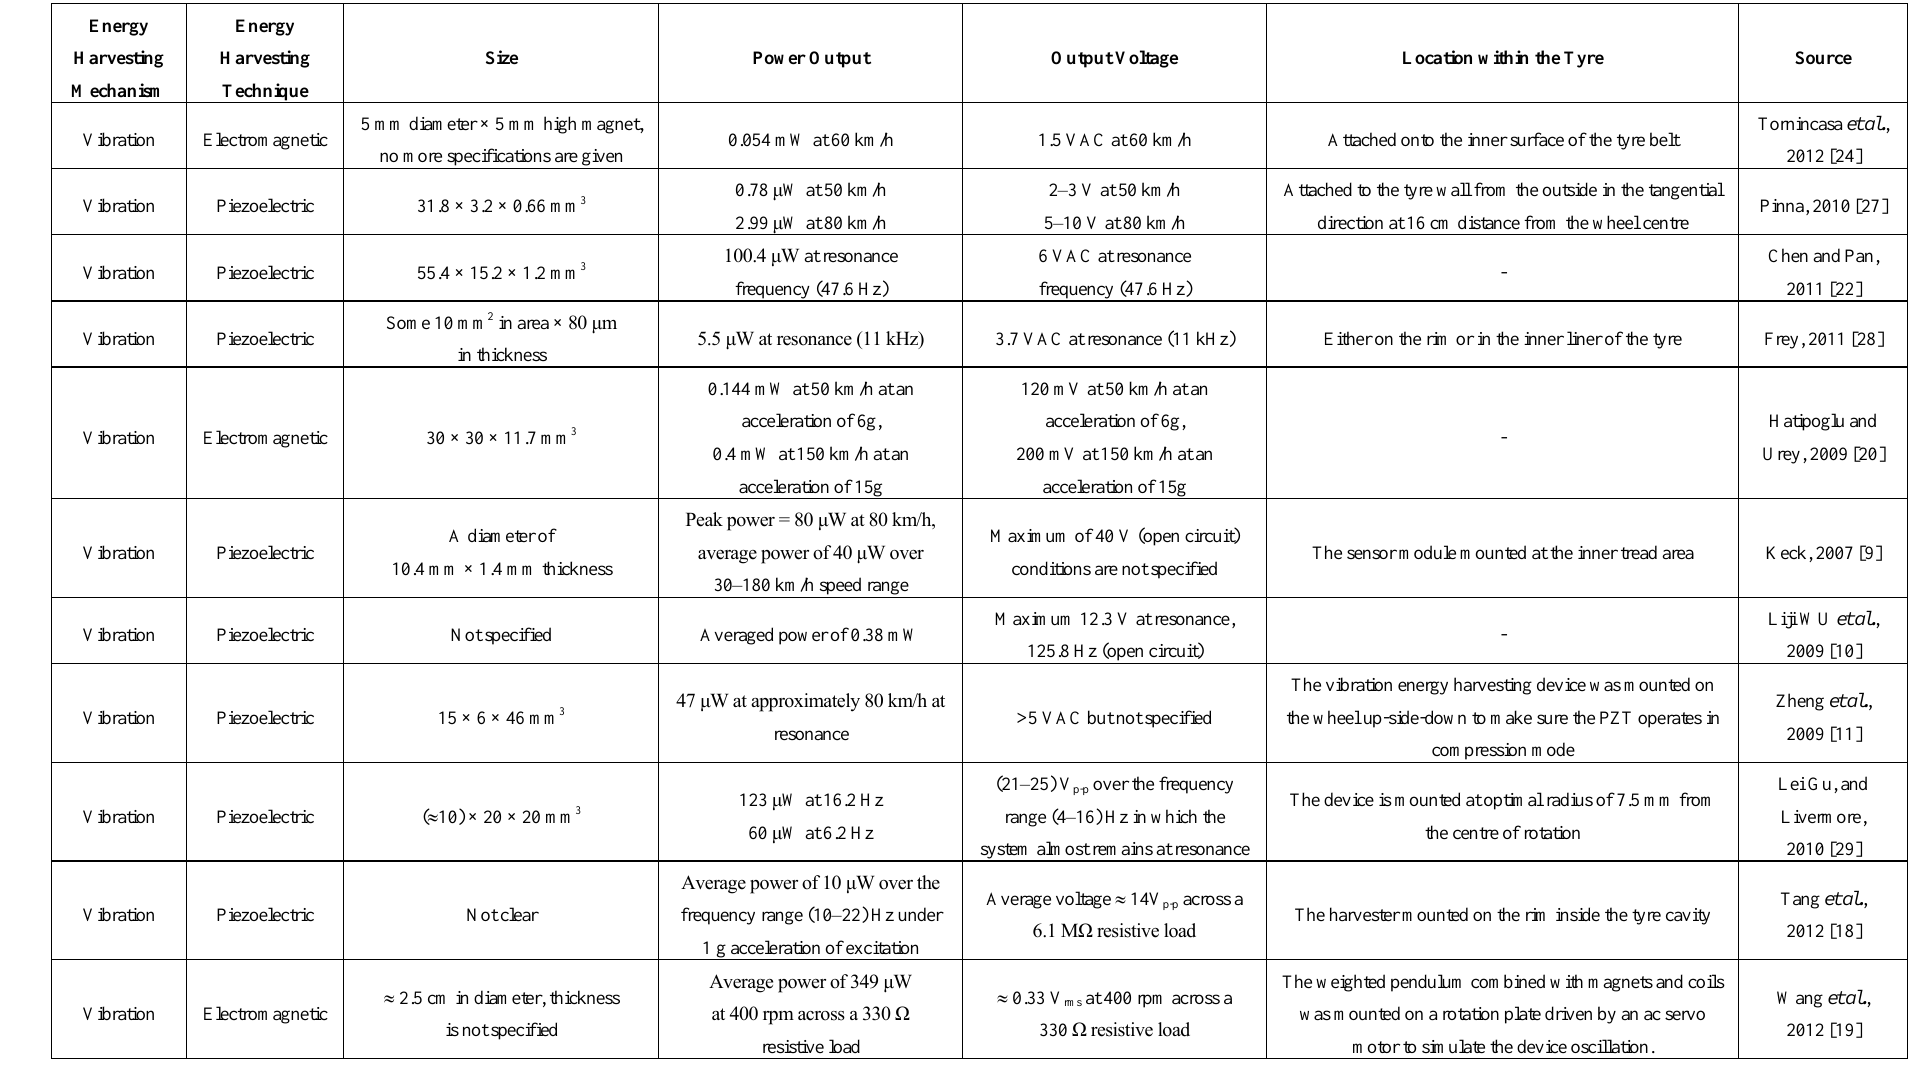
Table 1. Summary of published research for energy harvesters designed potentially for self powered